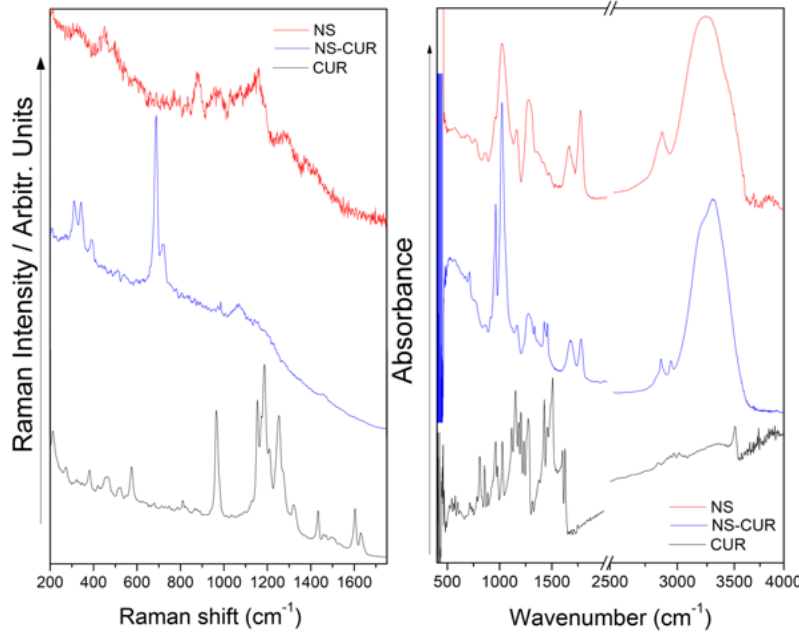
Figure 8. Raman ( left ) and FT-IR spectra ( right ) of NSs, CUR and NSs–CUR.